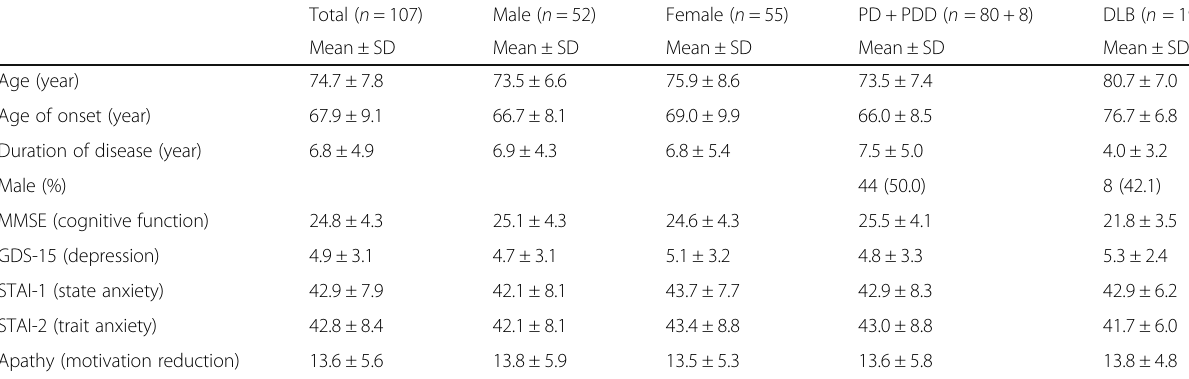
Table 2 Basic attributes of subjects